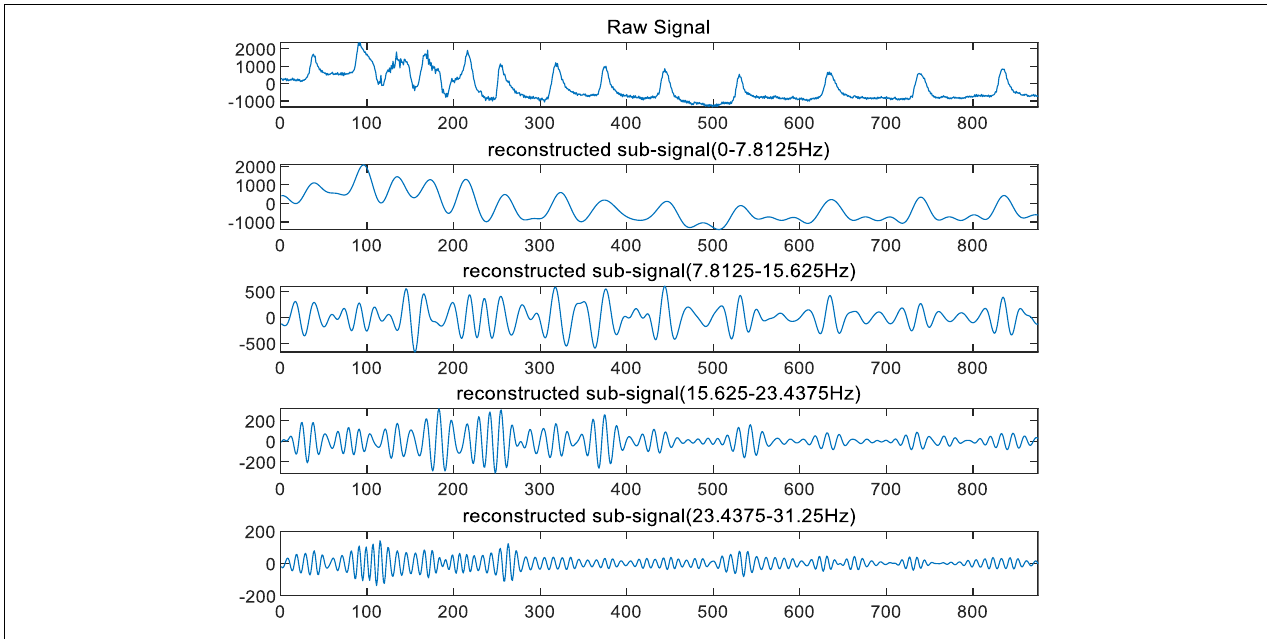
FIGURE 2 | Examples of short EEG recordings and their reconstructed sub